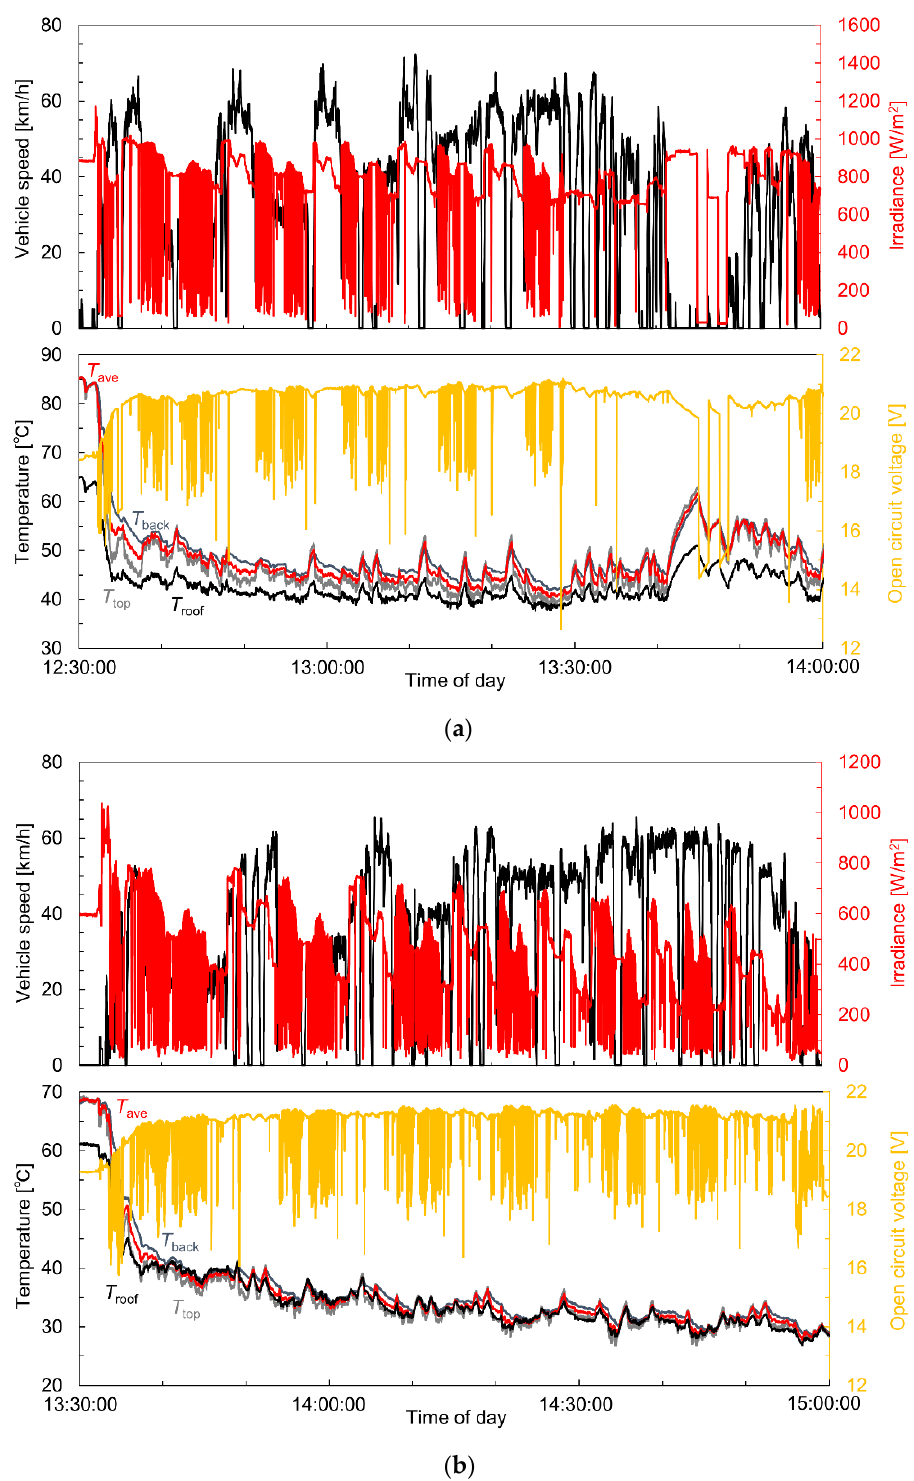
Figure 10. Measured values in the daytime experiment: ( a ) small van and ( b ) sedan. The upper graph shows the vehicle speed (black) and solar irradiance at P1 (red). The lower graph shows the module top surface temperature T top (gray), back surface temperature T back (blue), and average temperature T ave (red) at T1. T ave is the average of T top and T back . The open circuit voltage V oc of the VIPV module is also shown (yellow).